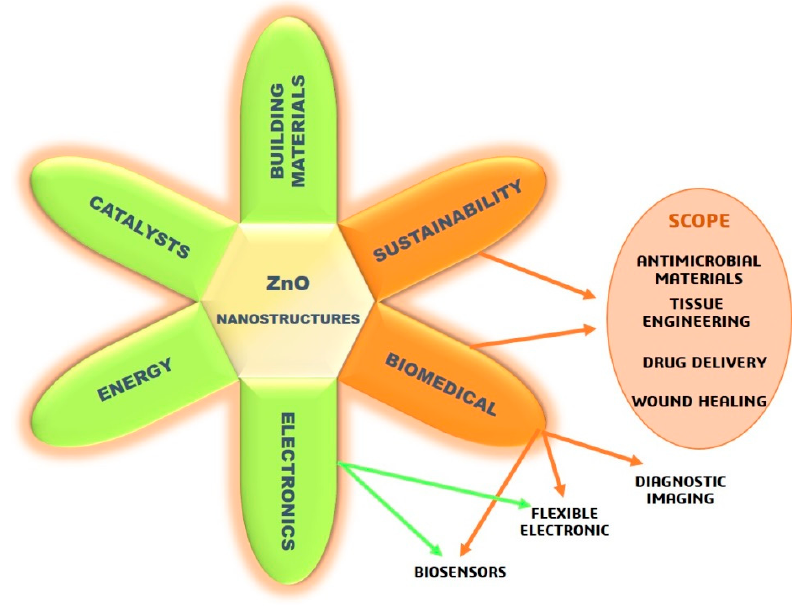
Figure 1 . Applications of ZnO nanostructures, focusing on biomedical health and sustainability. Figure 1. Applications of ZnO nanostructures, focusing on biomedical health and